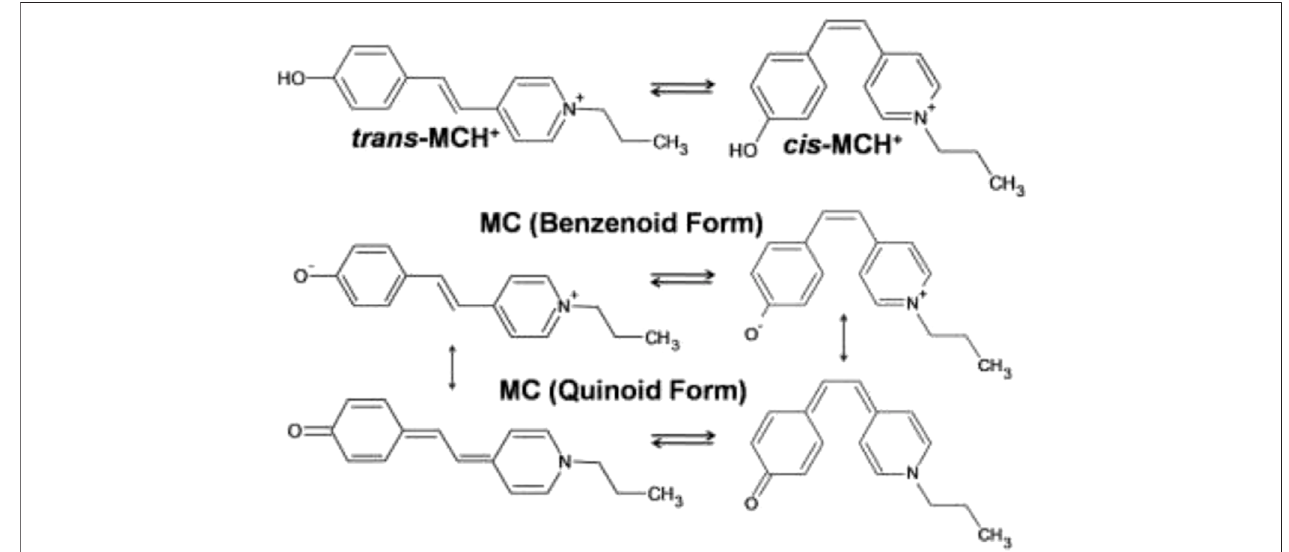
SCHEME 1 | Molecular structures of the trans - and cis -conformers of protonated (MCH + ) and deprotonated (MC) forms of merocyanine dye [4 ’ -(hydroxystyryl)-4- propylpyridinium bromide].